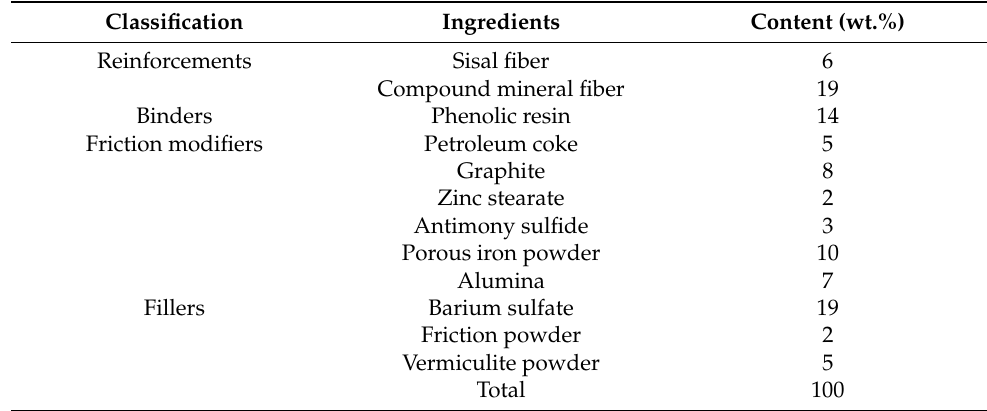
Table 1. Formulation of the prepared composite materials.